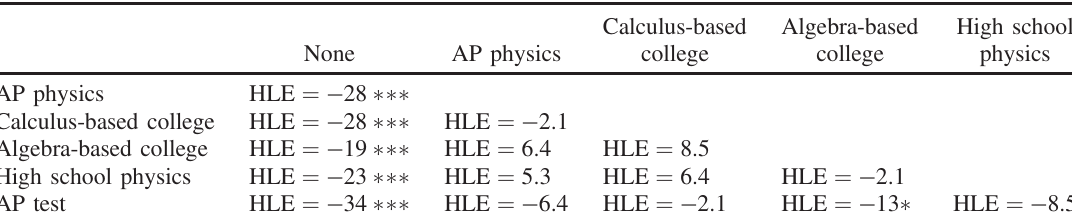
TABLE I. Pairwise comparisons of FMCE prescores by prior physics experience. Differences between pseudomedians are computed using the Hodges-Lehmann estimator (HLE), and the statistical significance of each difference is computed using the Mann-Whitney U test, corrected for multiple comparisons. The sign of HLE estimates is determined by column group minus the row group. (cid:2) p < 0 . 05 , (cid:2)(cid:2) p < 0 . 01 , (cid:2)(cid:2)(cid:2) p < 0 . 001 .